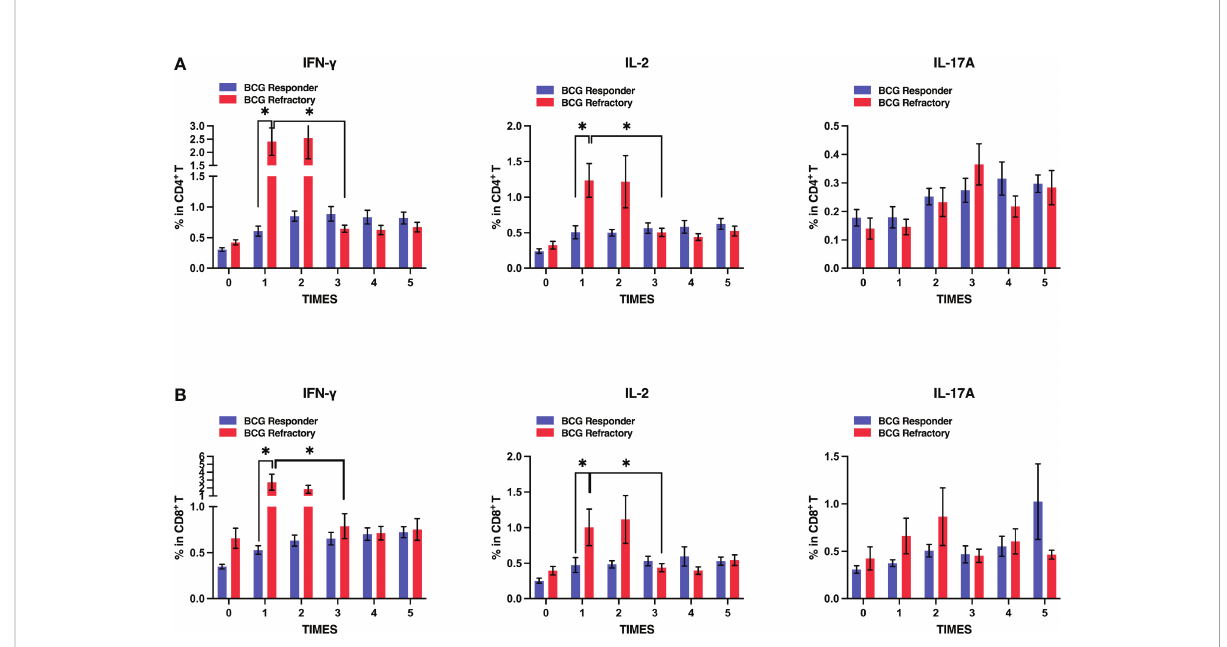
FIGURE 5 Dynamics of antigen-speci fi c cytokines secretion by T cells in BCG responder and BCG refractory patients at the induction phase. Blood samples were collected and PBMCs were subjected to PPD stimulation and fl ow cytometric assays serially at the induction phase. (A, B) Frequencies of PPD-speci fi c IFN- g , IL-2, and IL-17A releasing CD4 + (up) or CD8 + T (down) cells in two groups. Data are represented as the mean ± SEM. P values were calculated using analysis of variance. *P <